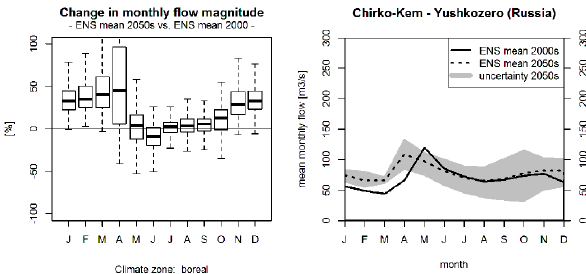
Fig. 8. Direction of change in the 2050s plotted for all grid cells of the polar climate zone (left) and the Altaelva river near Kista (right).